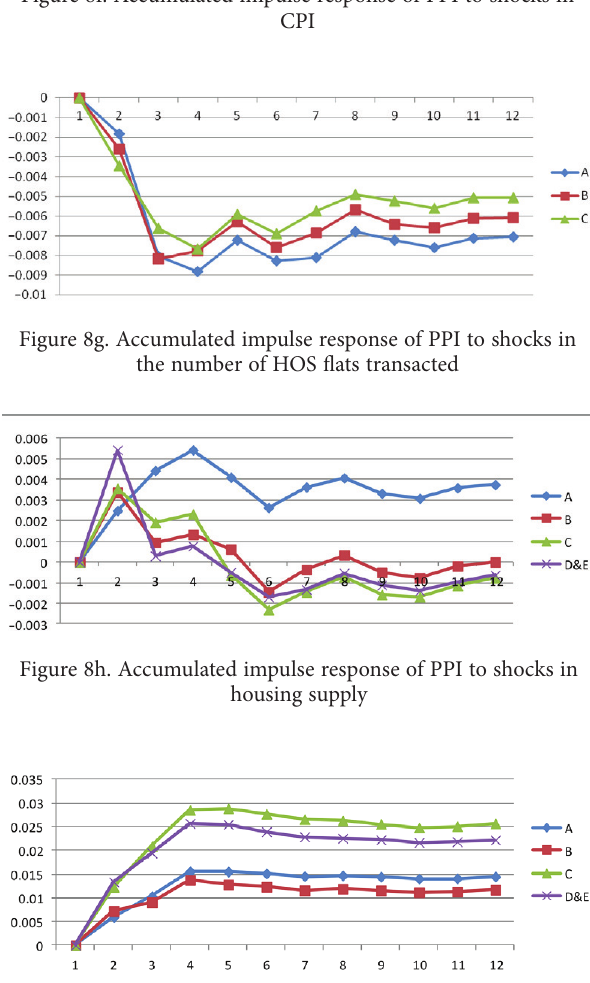
Figure 8a. Accumulated impulse response of PPI to shocks in